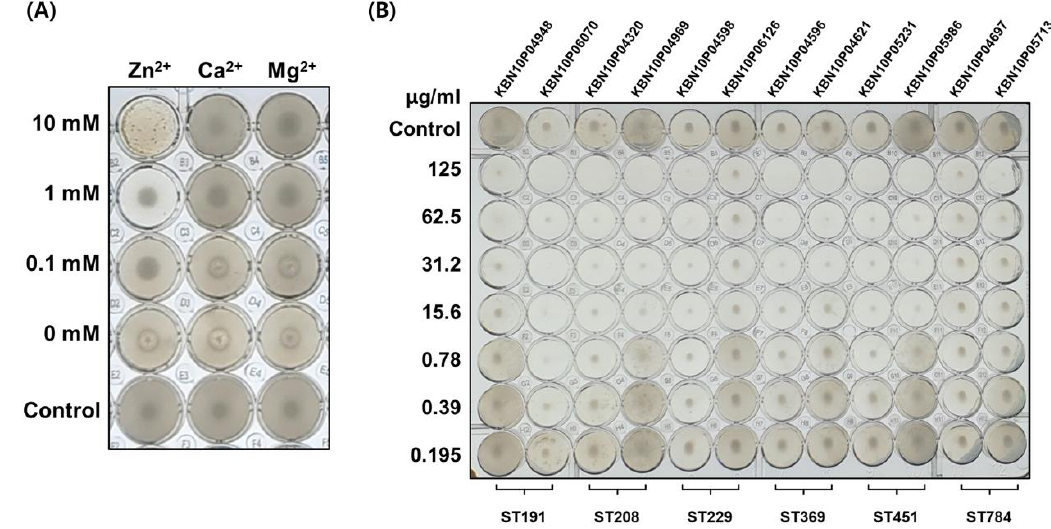
Figure 5. Antibacterial activity of AbEndolysin. ( A ) Identification of cofactor of AbEndolysin. The concentration of AbEndolysin was fixed, and the divalent ions Zn 2+ , Ca 2+ , and Mg 2+ were treated at concentrations of 10 mM, 1 mM, 0.1 mM, and 0 mM, respectively. ( B ) Antimicrobial activity of AbEndolysin against MDR- A. baumannii clinical strains (ST-191, ST-208, ST-229, ST-369, ST-451, and ST-784). AbEndolysin was serially diluted two-fold from the highest concentration of 125 µ g/mL to confirm its inhibitory concentration. Fresh bacterial culture in MHB was used as control.